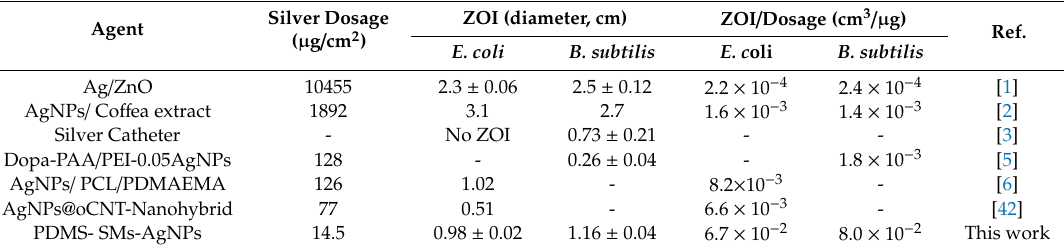
Supplementary Materials: Figure S1: Optical microscope graph of PDMS with different concentrations of SMs-AgNPs were assembled on their surface. Figure S2: Growth of E. coli on the surface of PDMS, PDMS-SMs, PDMS-SMs-AgNPs (sparse/tight). Figure S3: ZOI assay of PDMS and PDMS-SMs-AgNPs with Bacillus subtilis after 24 h incubation at 37 °C. Figure S4: Growth of Bacillus subtilis on the surface of PDMS, PDMS-SMs,